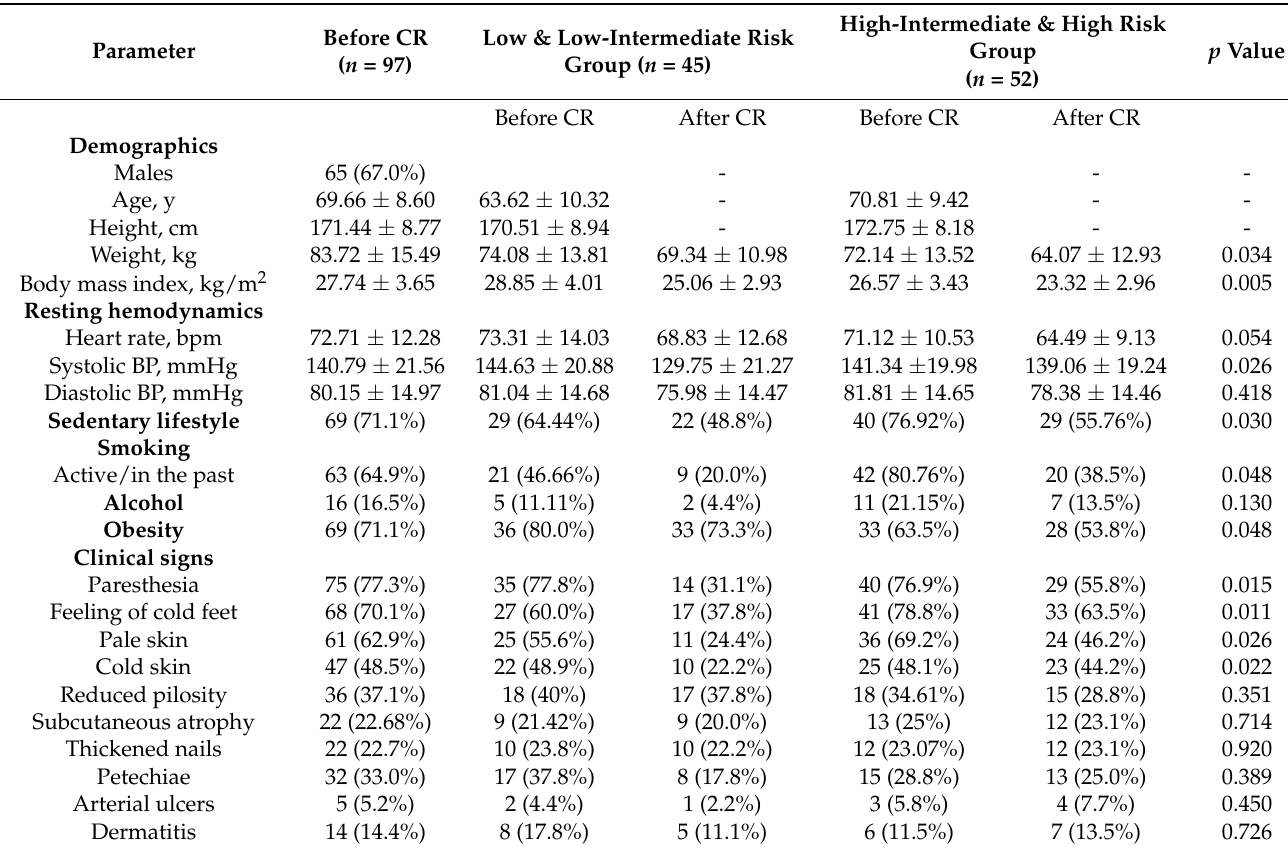
Table 1. Demographics, resting hemodynamics, and clinical